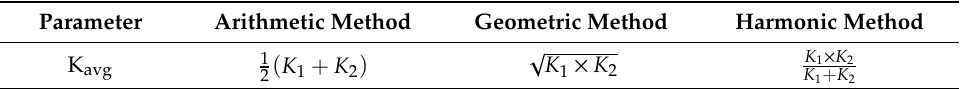
Table 5. The averaging methods for hydraulic conductivity in